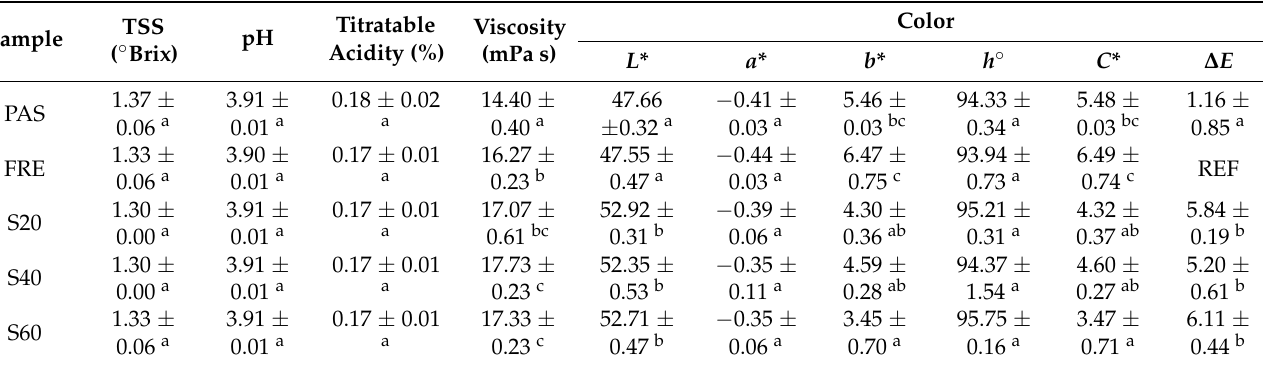
Table 1. Total soluble solids, pH, titratable acidity, viscosity, and